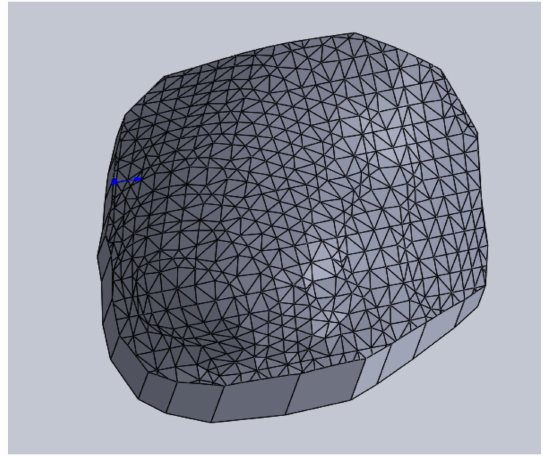
Figure 4. Full-fledged 3D model of the